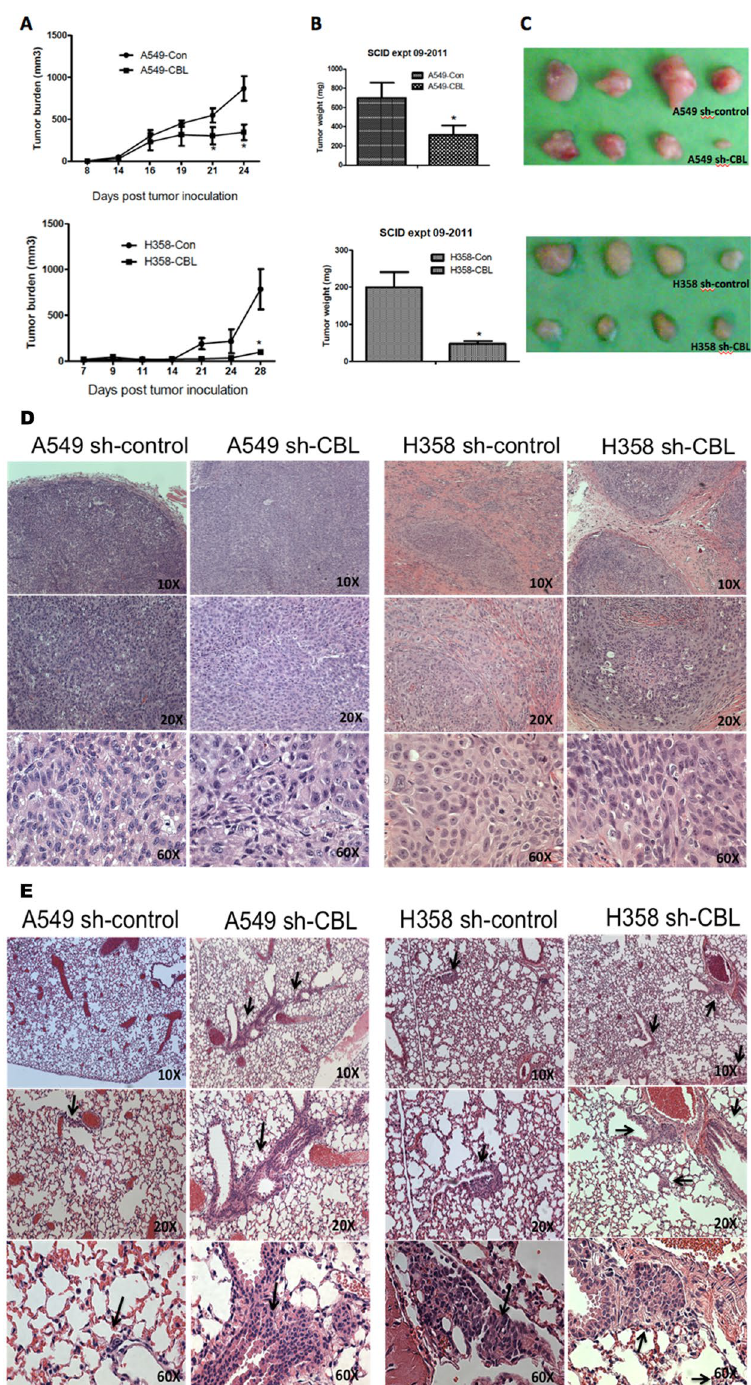
Figure 7. Tumor growth of CBL knockdown cells in mouse xenograft model. (A) Tumor was assessed three times a week. sh-control (con) of A549 and H358 cells showed more rapid growth of tumor than sh-CBL (CBL) cells. (B) Tumor weight of sh-CBL groups in A549 and H358 cells showed a significant difference compared with sh-control ( * p < 0.05). (C) Photograph of tumors from 4 mice of sh-control and sh-CBL groups in A549 and H358 cells. (D) H&E staining of primary tumors from sh-control and sh-CBL groups in A549 and H358 cells at 10x, 20x, and 60x magnifications. (E) Metastasis study of CBL knockdown cells in vivo . H&E staining of lung tumors showed more tumor metastasis results by pathologist’s reading from the subcutaneous injection site to the lung in both A549 and H358 sh-CBL cells than in sh-control cells. Metastatic tumors shown by black